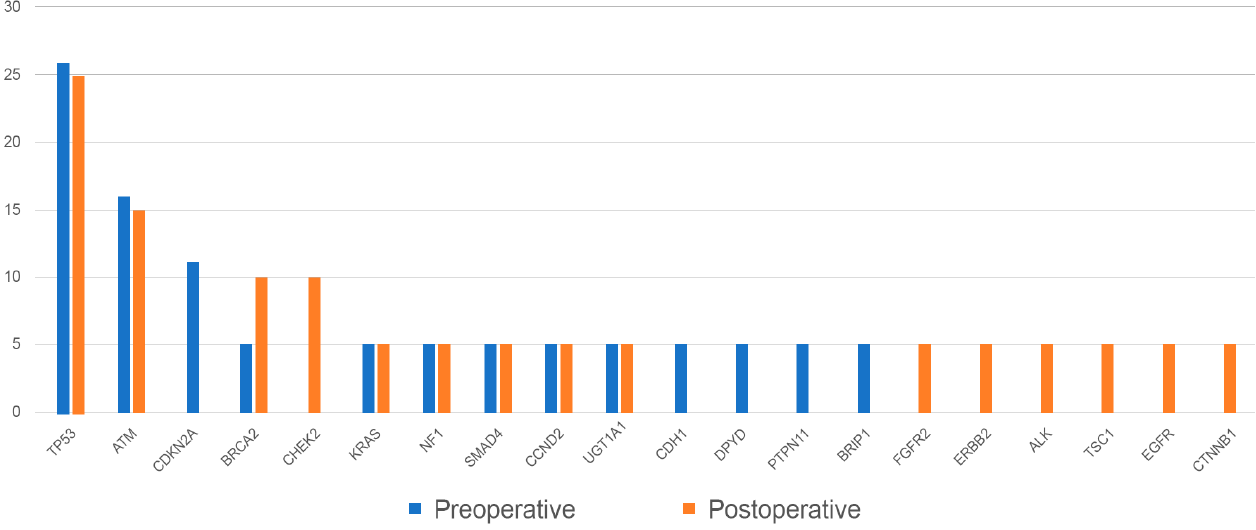
Figure 3. Changes of frequency of alterations of mutated genes in preoperative and postoperative ctDNA samples of patients with cholangiocarcinoma.